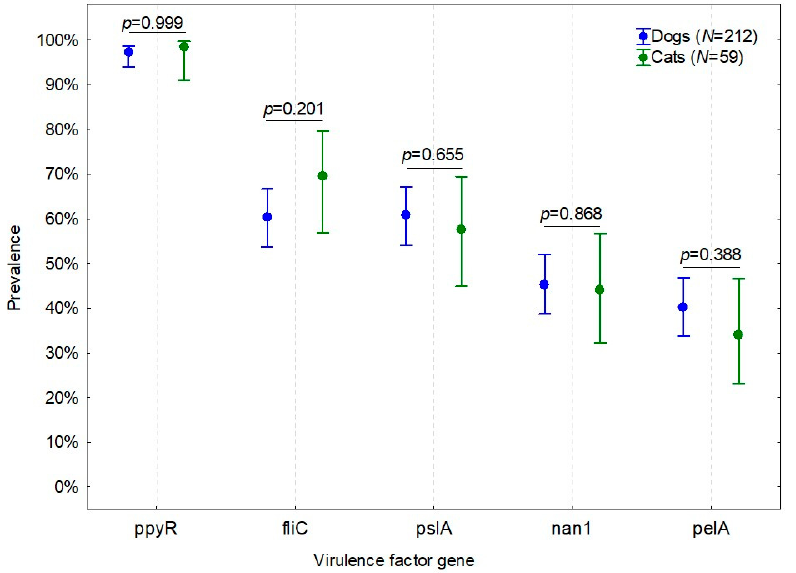
Figure 2. Prevalence (CI 95%) of virulence factor genes in P. aeruginosa strains isolated from dogs and cats.